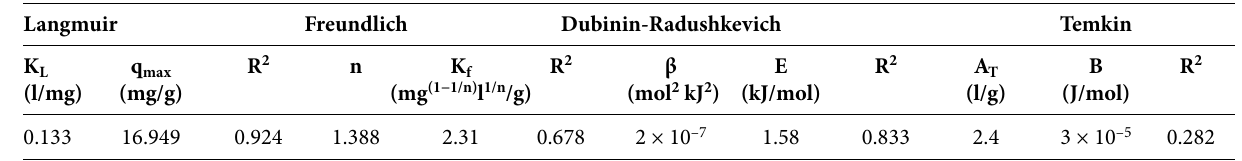
Table 4. Parameters of isotherm models (C i = 20-100 mg/L, 1.5 g biomass, 160 µm, 700 rpm, pH = 6.0±0.2, T = 20±1 o C, P = 1atm) Langmuir Freundlich